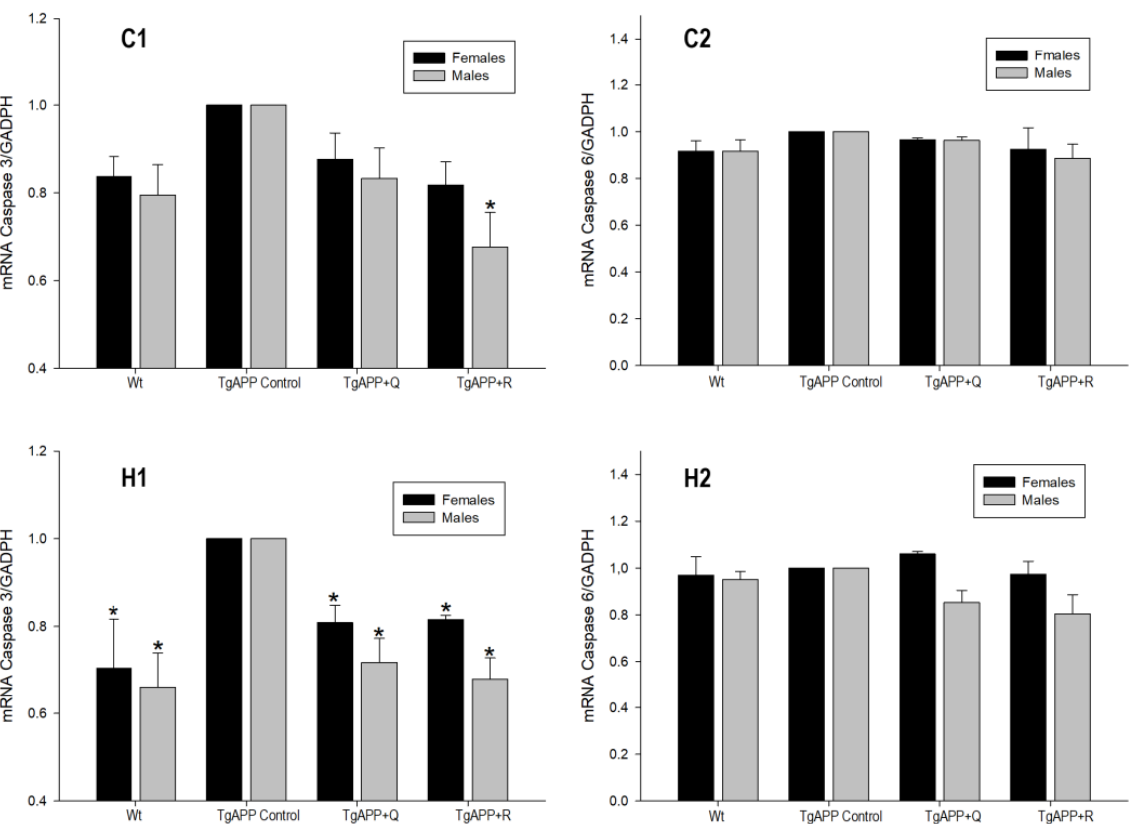
Figure 8. Effect of quercetin (Q) and rutin (R) on Caspase-3 (C1, H1) and Caspase-6 (C2, H2) expression in the Cortex (C) and the Hippocampus (H). (1) WT; (2) TgAPP control; (3) TgAPP + Q; (4) TgAPP + R. * p < 0.05 vs. TgAPP control (ANOVA followed by the post-hoc Newman–Keuls multiple comparison test).